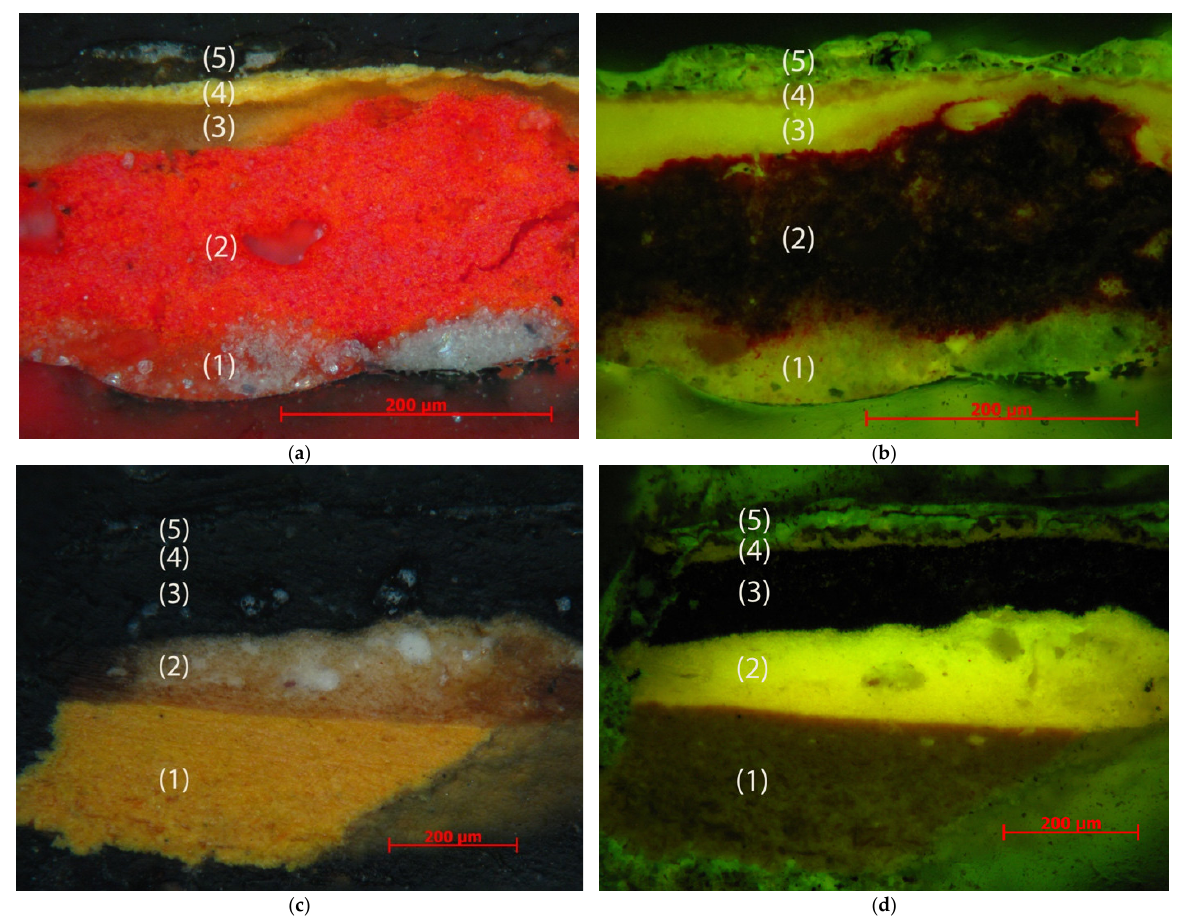
Figure 2. Sample cross sections D17 ( a , b ) and D14 ( c , d ). Cross sections in ( a , c ) visible-reflected light and ( b , d ) UV fluorescence (λexc = 365 nm) are shown. Complete stratigraphy for ( a ) and ( b ) is as follows: (1) first layer of gesso ground: gypsum; (2) first painting layer: cinnabar and grains of carbon black; (3) second layer of gesso ground: gypsum; (4) second painting layer: orpiment; (5) varnish. For ( c ) and ( d ): (1) first painting layer: orpiment; (2) layer of gesso ground: gypsum, calcite, and orpiment; (3) second painting layer: carbon black; (4) first varnish layer; (5) second varnish layer.